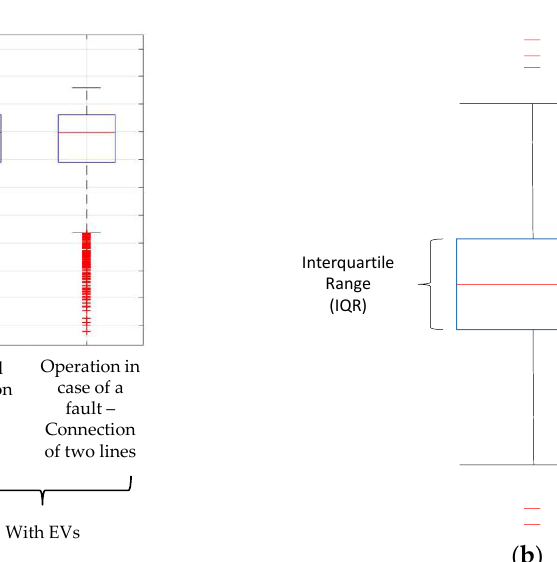
Figure 7. Maximum loading of the lines in Astypalea when considering the presence of EVs. The minimum voltage values that were noted when applying simulations for the time period of one year are depicted in Figure 8. Due to the small length of the lines and the relatively small increase in peak demand (~5%), no issues should be expected with minimum voltages. In particular, EV charging reduces voltages; however, the relevant values remain within the required limits.